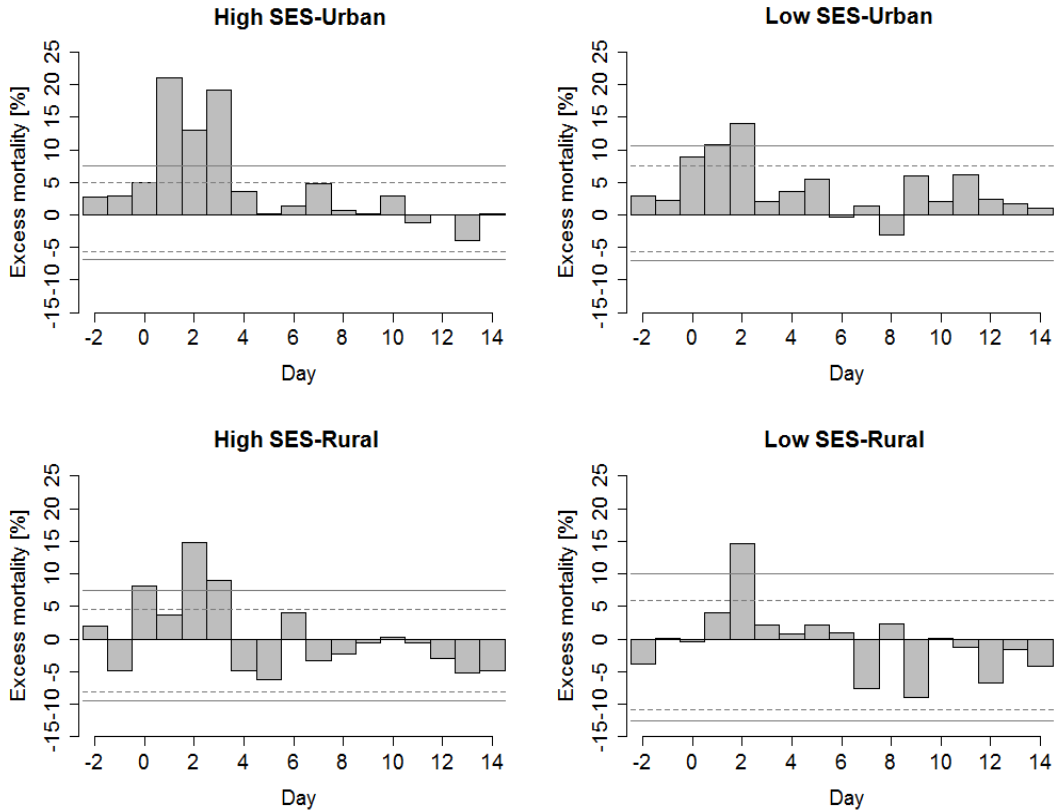
Figure 6. Mean relative excess mortality due to CVDs on days D − 2 to D + 14 around a hot spell’s onset in the groups of districts . Confidence bounds around the zero line are indicated by dashed (90%) and solid (95%) lines, respectively.